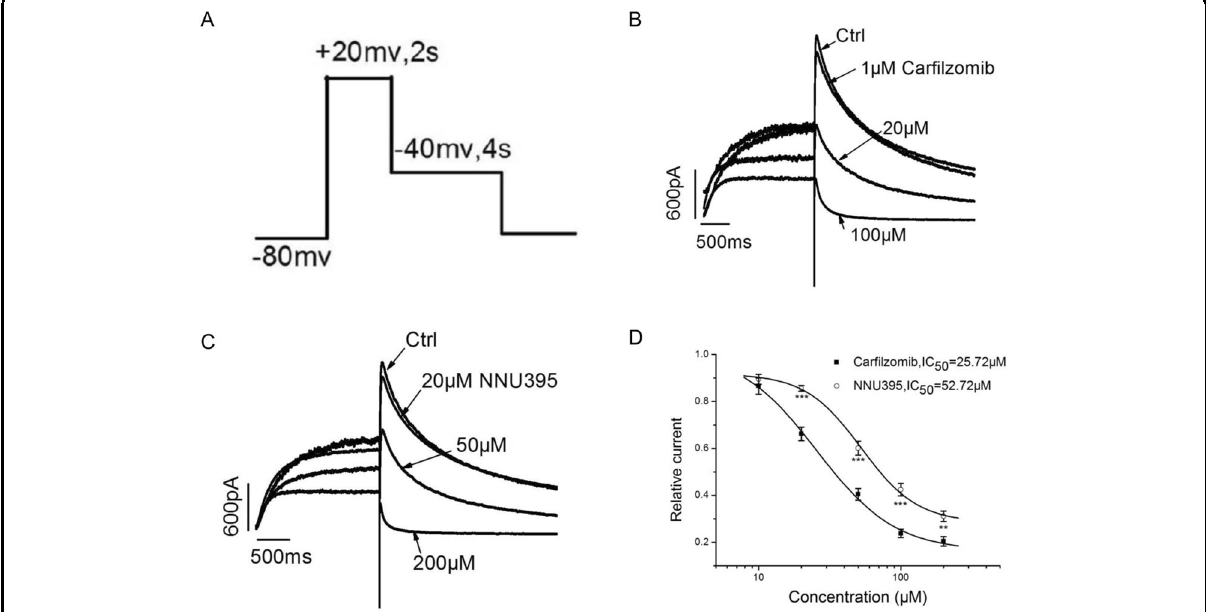
Fig. 8 Effects of D395 and car fi lzomib on hERG channels. A The command waveform of the tail-current protocol under voltage-clamp mode. B , C Increasing doses of D395 (20 µM, 50 µM, and 200 µM) or car fi lzomib (1 µM, 20 µM, and 100 µM) inhibited outward potassium currents. D The inhibitory activities of D395 and car fi lzomib in tail current were merged and shown as a diagram